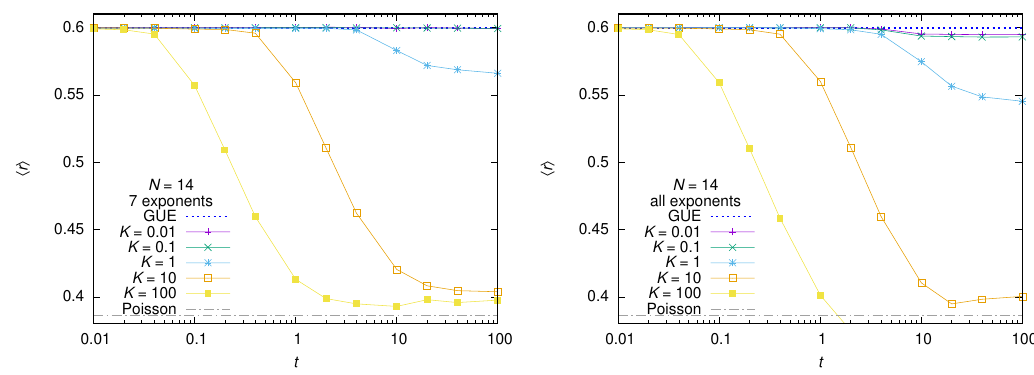
Figure 17 . The r -parameter h r i for the N = 14 SYK model, with (cid:12)xed- i unfolding, obtained by [left] using the larger N= 2 = 7 exponents, and [right] using all the exponents. The early time behaviors are almost identical. (Di(cid:11)erent late time behaviors appear because a large gap sets in between (cid:21) and (cid:21) .) At K = 10 and 100, large deviation from the GUE value is observed N= 2 N= 2+1 before the Lyapunov growth (with almost constant Lyapunov exponent) sets in. At K = 1, a large deviation is observed before the Lyapunov growth ends. At K = 0 : 01 and 0 : 1, the r -parameter stays close to the GUE value even at t =